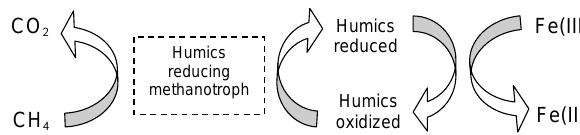
Fig. 4. Conceptual mechanism for CH 4 oxidation linked to hu- mic substance mediated Fe(III) reduction. Adapted from Scott et al.